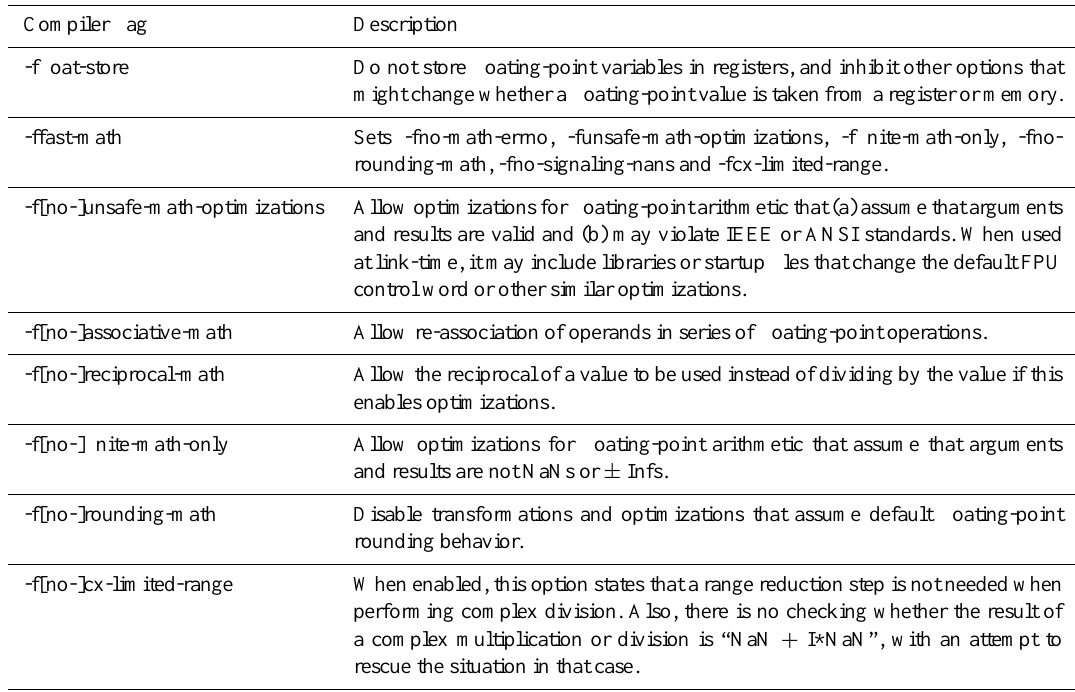
Table 5. GCC compiler optimization options that may impact the precision of floating-point calculation. They are common to the compiler versions listed in Table 4.